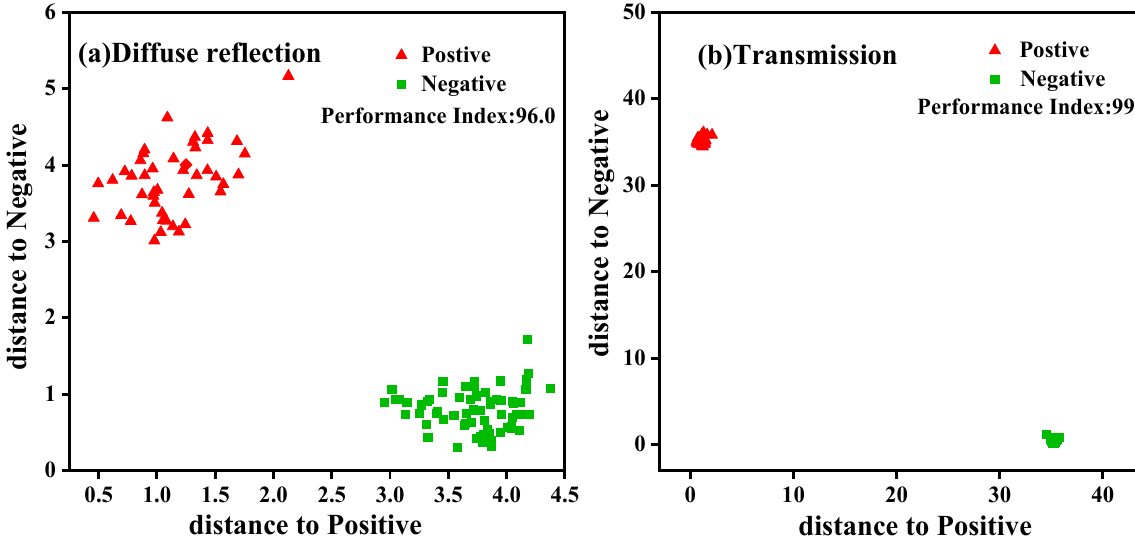
Figure 7. Principal component Mahalanobis distance discriminant analysis models.